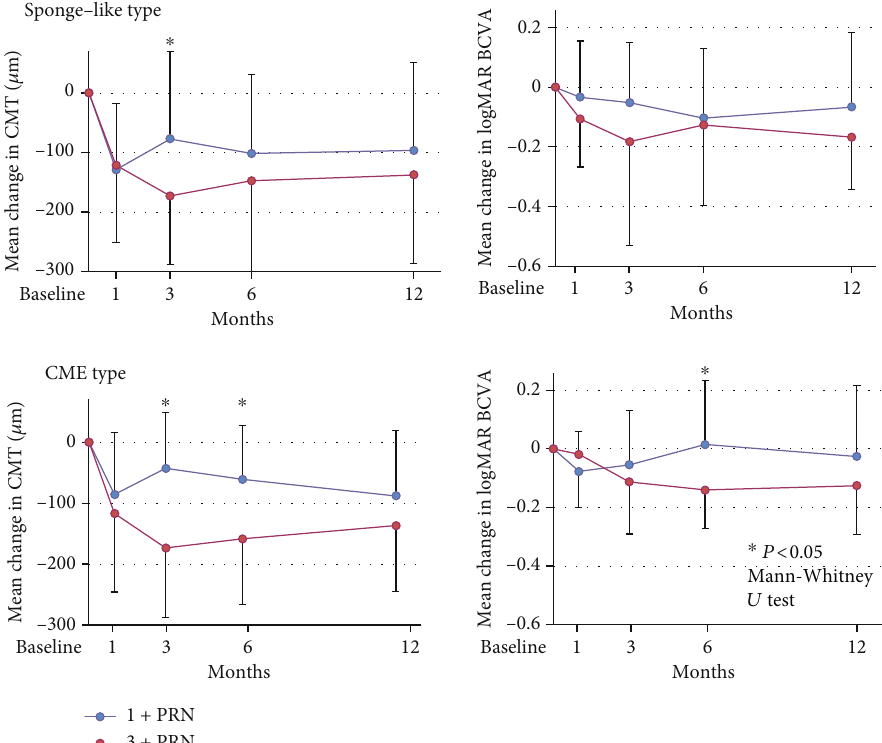
Figure 7: Changes in the mean BCVA (logMAR units) and the mean CMT from baseline to 12 months after the IVA for CME and sponge- like DME. There were no signi fi cant di ff erences both in the mean BCVA and in the mean CMT between the 1+PRN and 3+RPN in eyes with CME and sponge-like DME at 12 months. PRN: pro re nata ; CMT: central macular thickness; BCVA: best-corrected visual acuity; logMAR: logarithm of the minimum angle of